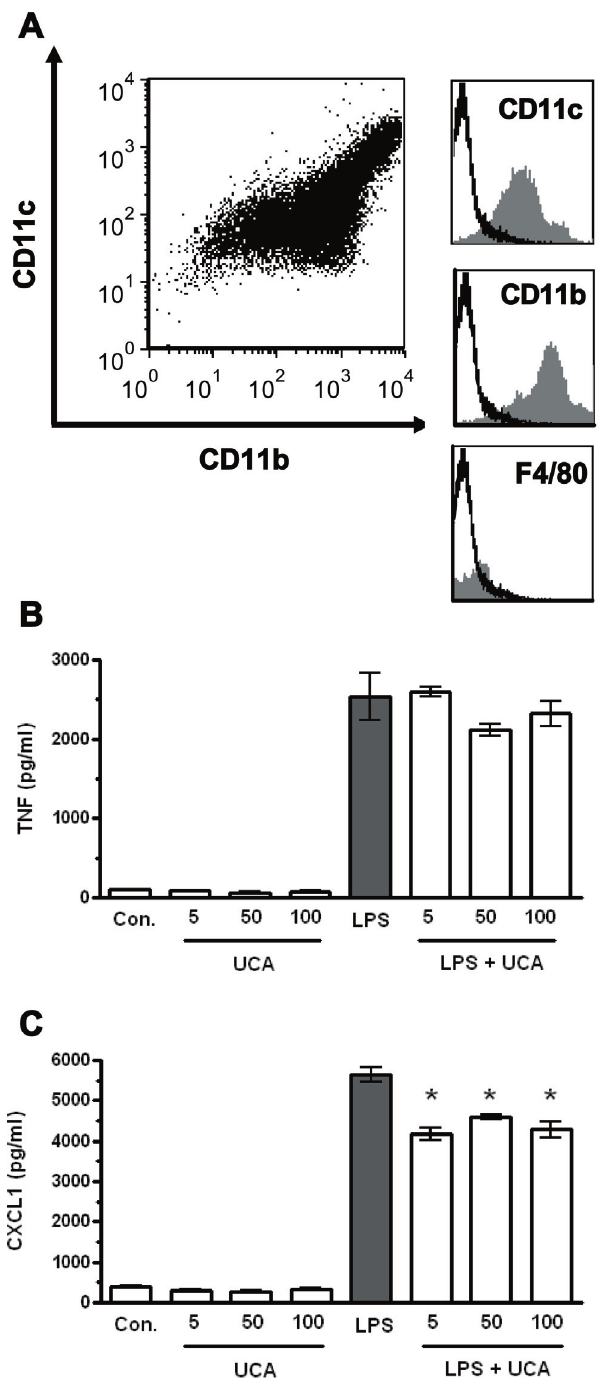
Figure 4. Effect of cis -UCA on lipopolysaccharide (LPS)-induced cytokine secretion by bone-marrow-derived antigen present- ing cells (BM-APC). BM-APCs derived from long-bones of 129 Sv/EV mice (1 6 10 6 cells/ml) were pre-treated for 2 hrs with cis -UCA (5 m g, 50 m g, or 100 m g) and then stimulated with LPS (1 m g/ml). Supernatants were collected after 24 hrs. Unstimulated BM-APCs were CD11b + , CD11c + and F4/80 2 (A). LPS induced TNF a secretion from BM-APCs and this was not altered by the presence of cis -UCA (B). LPS also